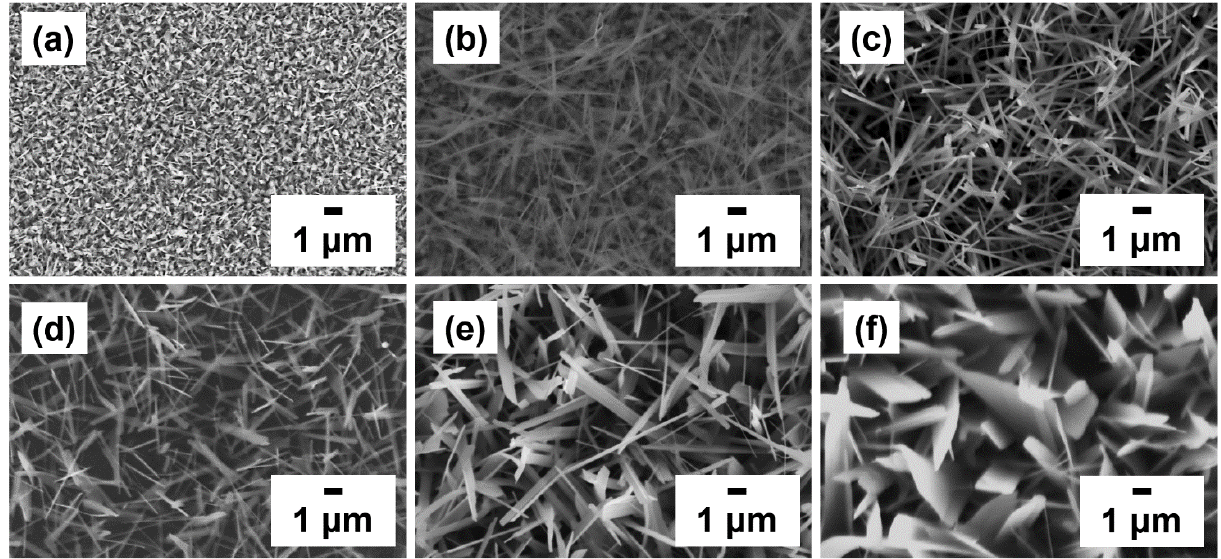
Figure 2. Top-view SEM images of gallium telluride (GaTe) nanowires and nanosheets sample grown on c -sapphire with different growth times: GaTe nanowires ( a ) 5 min, ( b ) 20 min, and ( c ) 60 min and GaTe nanosheets: ( d ) 5 min, ( e ) 20 min, and ( f ) 60 min.